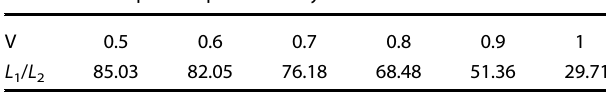
Table 1. Principal component analysis.